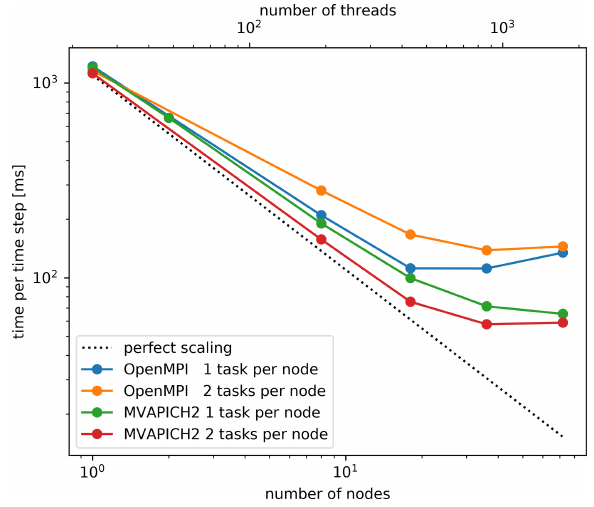
Figure A1. Strong scaling test of the libmpdata++ library. Wall time per time step of a dry planetary boundary layer simulation. The dot- ted black line shows perfect